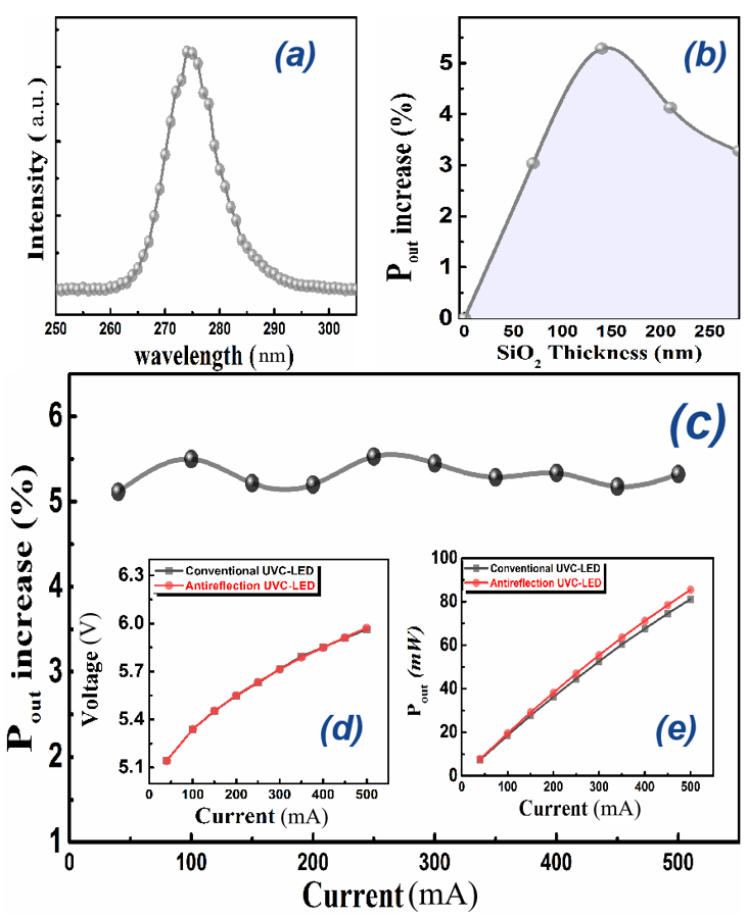
Figure 2. ( a ) EL spectra of the DUV-LEDs; ( b ) the P out increase with different SiO 2 thicknesses; ( c ) the P out increase with current with 140 nm SiO 2 ; ( d ) I–V characteristic; and ( e ) I–L characteristic. For specifying the origin of LEE enhancement in UVC-LEDs, 0–280 nm SiO 2 were also deposited onto Al 2 O 3 substrate to form SiO 2 /Al 2 O 3 double layers. Transmitted spectrums of these layers were simulated and experimentally measured. Figure 3 shows a schematic of SiO 2 /Al 2 O 3 film, which was loaded to simulate the light transmittance at different incident angles θ and wavelengths. Figure 4a shows the transmission spectra with different SiO 2 thicknesses at normal incidence ( θ = 0 ◦ ) by TFCALC. Figure 4b shows the experimental transmittances of bare Al 2 O 3 and 140 nm SiO 2 /Al 2 O 3 at normal incidence, which were consistent with the theoretical simulation in Figure 4a. The transmittance of 275 nm photon increases about 6% (Figure 4b)–6.25% (Figure 4a) by the 140 nm SiO 2 antireflective coating. Combined with the 5.5% elevation of antireflective 275 nm UVC-LED in Figure 2c, it was believed that the enhancement of transmission by 140 nm SiO 2 /Al 2 O 3 structure should be the dominant factor for higher EQE of antireflective UVC-LED. The mechanism of light-extraction enhancement at 140 nm SiO 2 is mainly due to the coherent suppression of two reflected light waves (R1 and R2 in Figure 3) when the light is incident from the Al 2 O 3 side. The first light wave, R1, is directly reflected by the Al 2 O 3 /SiO 2 interface and the second light wave transmits through the Al 2 O 3 /SiO 2 interface after being reflected ( 2n + 1 ) λ (R2) by the SiO 2 /air interface. When R1 and R2 interfere with phase difference, 2 coherent suppression of reflected light occurs, weakening the total reflected light and enhancing transmitted power. In this work, the enhanced transmittance of around 275 nm at a thickness of 140 nm comes from the coherent suppression effect by 3 λ phase 2